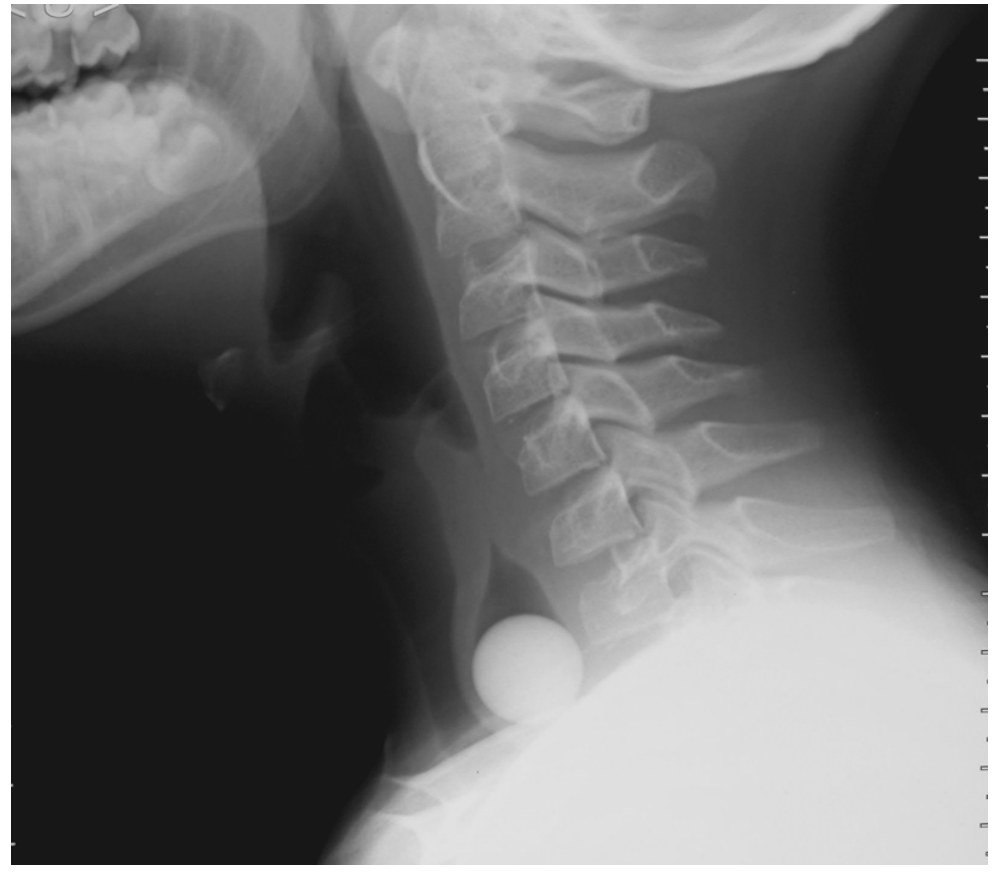
FIGURE 1. Lateral radiogram of the neck with a spherical ball above the thoracic inlet, pushing the posterior wall of the trachea anteriorly.